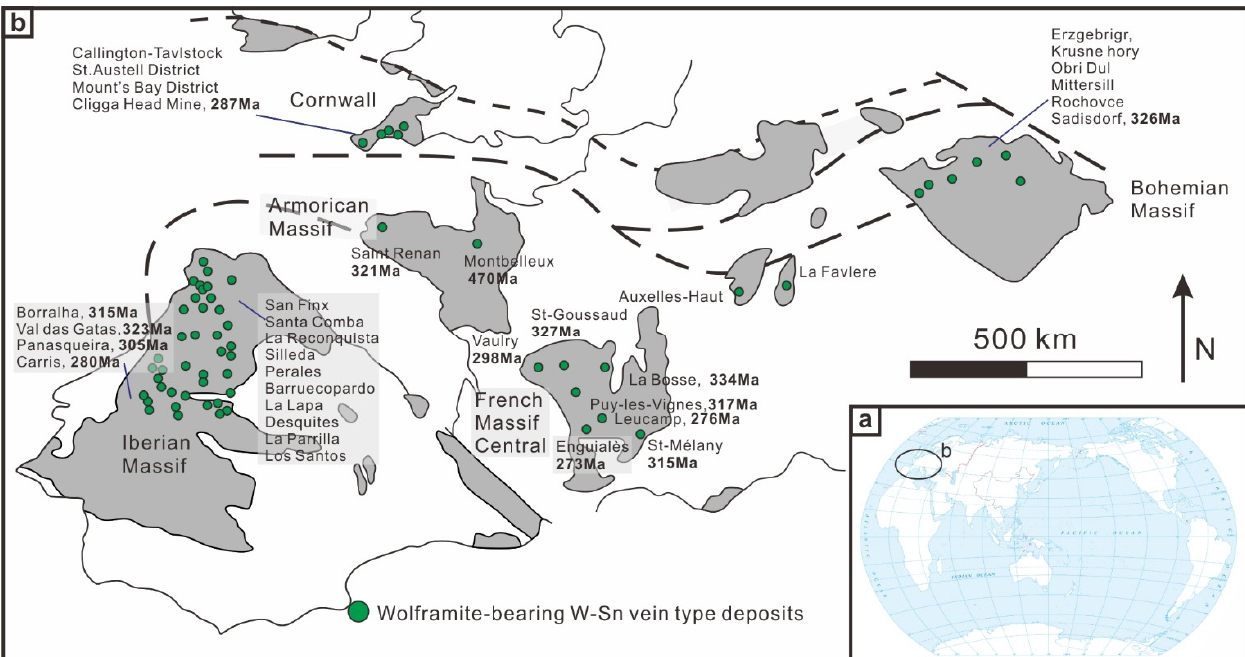
Figure 4. Simplified map showing the framework of W-Sn mineralization provinces in the Variscan belt, compiled based on the mineralization ages of selected deposits described in Table 1 (modified after [80]). Location of the European Variscan belt ( a ) and major occurrences of W-Sn deposit ( b ).